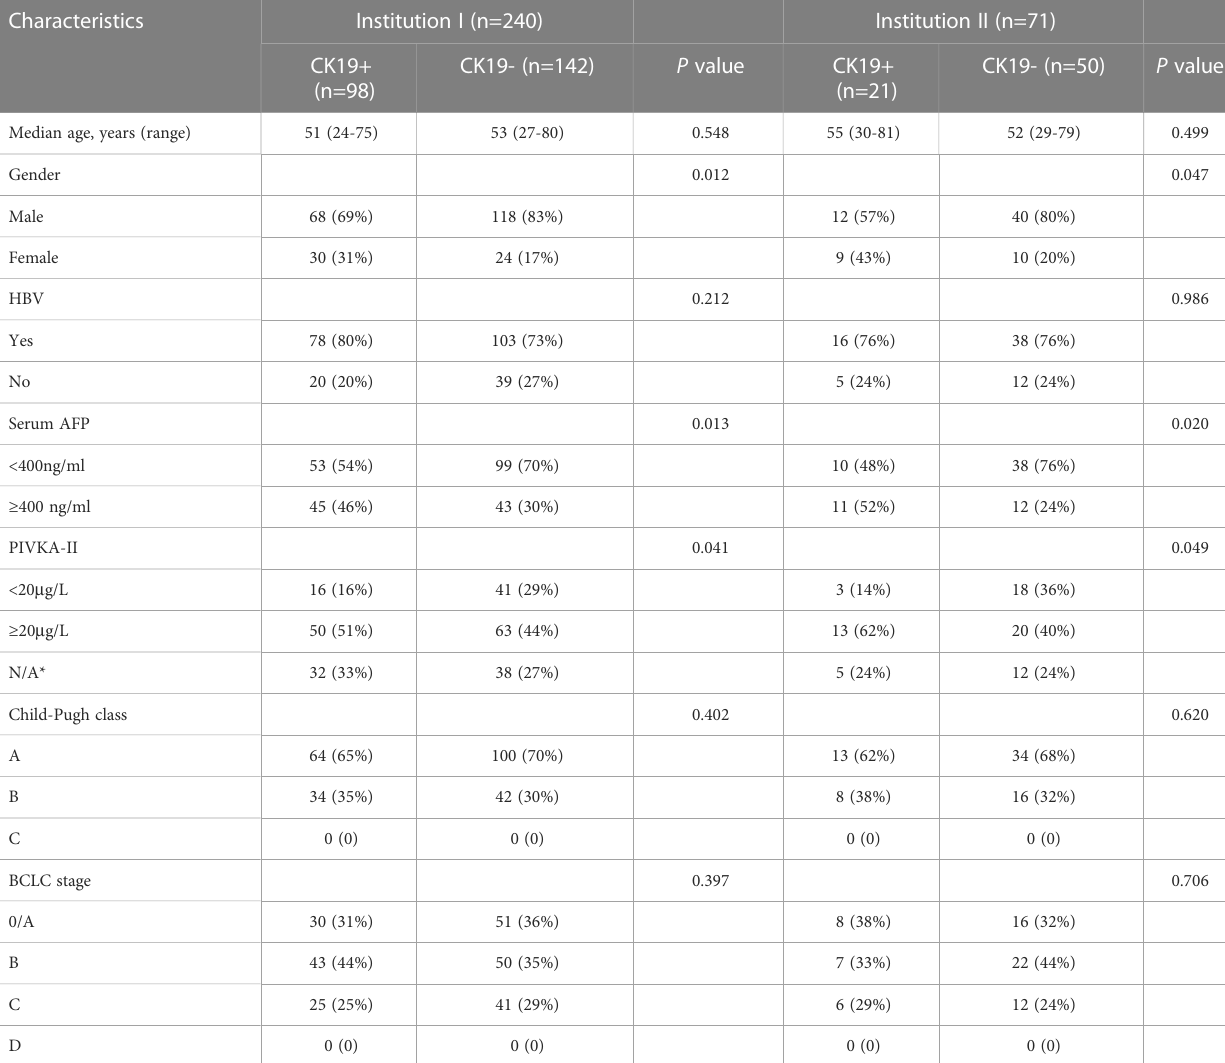
TABLE 2 Comparison of clinical characteristics according to CK19 status in institution I and institution II.